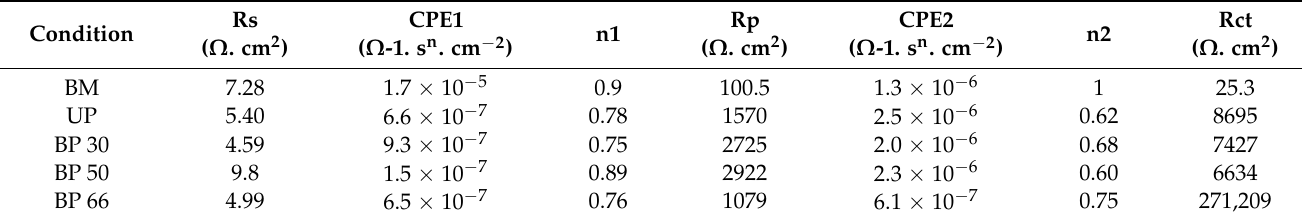
Table 4. EIS fitting results of the studied conditions in 0.5 M NaCl